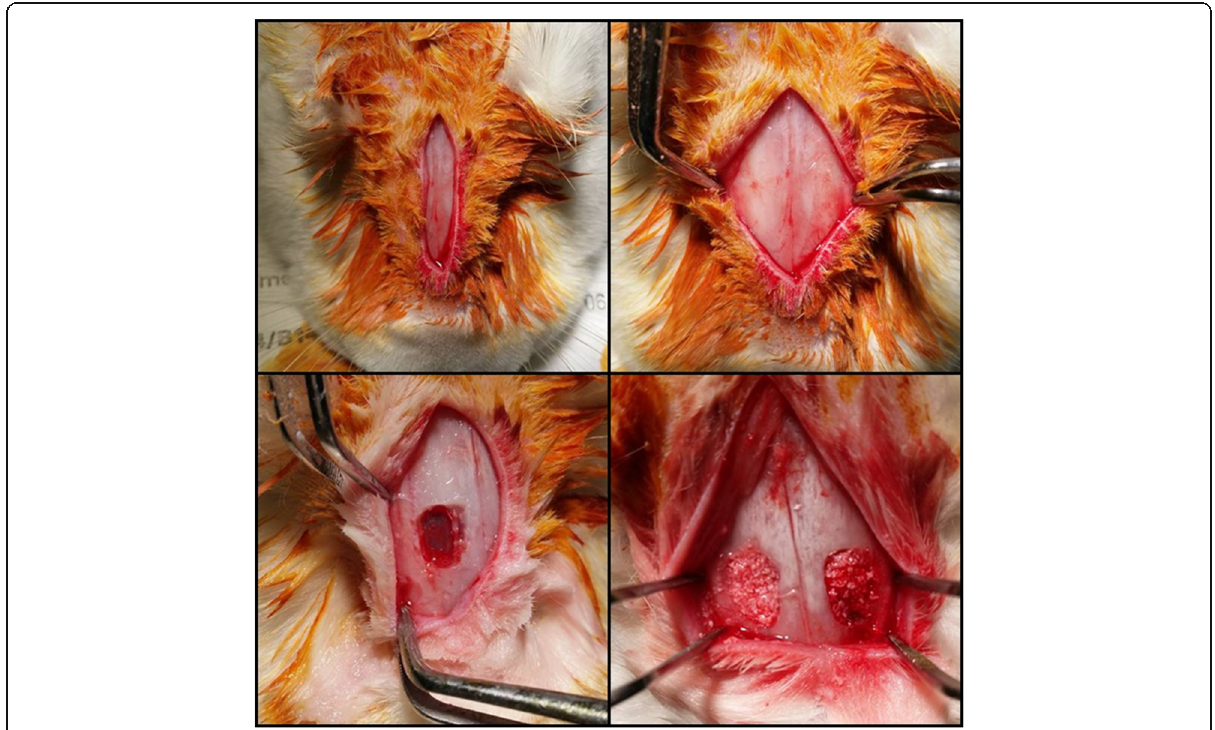
Fig. 1 Clinical photographs of surgical procedures. G 1, group 1, Bio-Oss®; G 2, group 2, Bio-Oss® mixed with